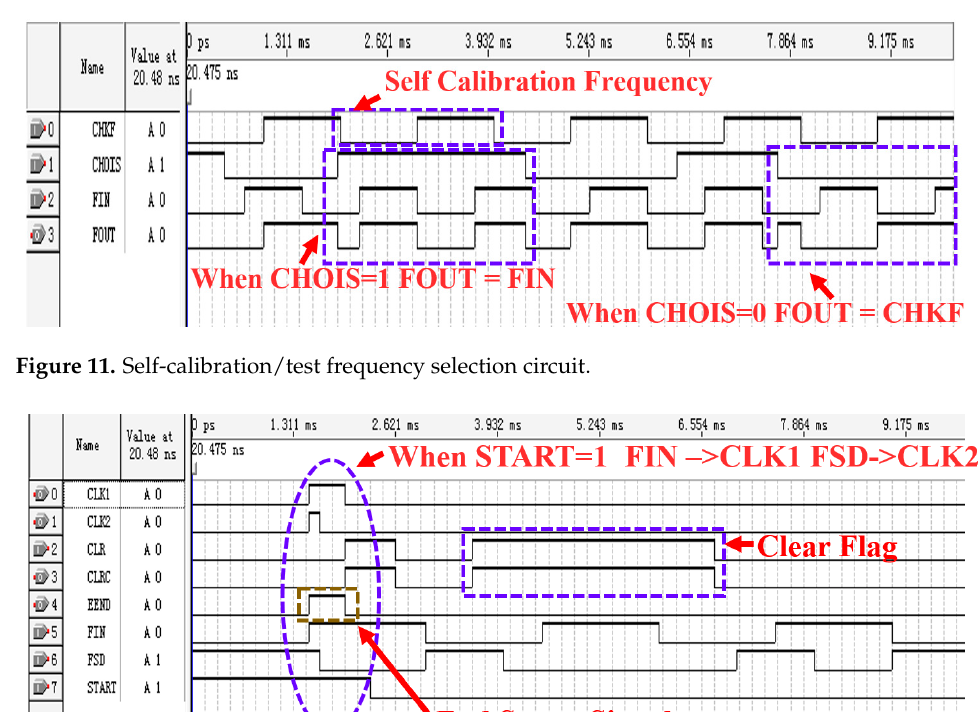
Figure 10. Pulse width measurement and duty cycle measurement.